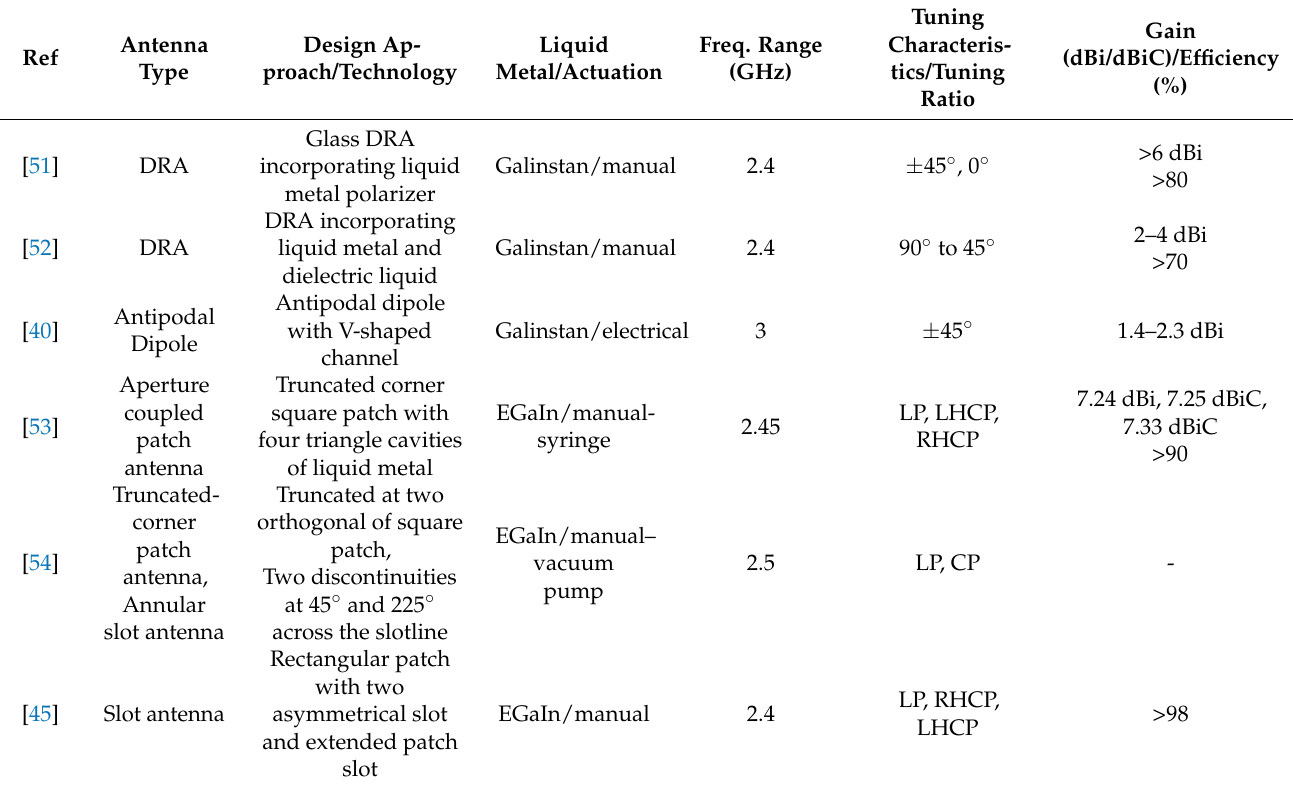
Table 3. Summary of polarization reconfigurable antennas using nontoxic conductive